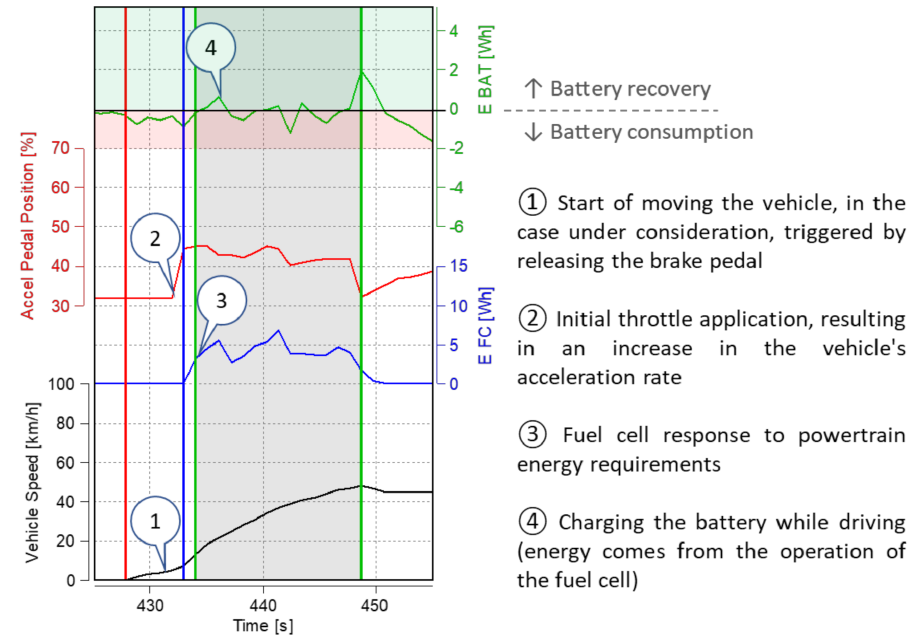
Figure 11. Analysis of a selected single acceleration process of a FC vehicle.